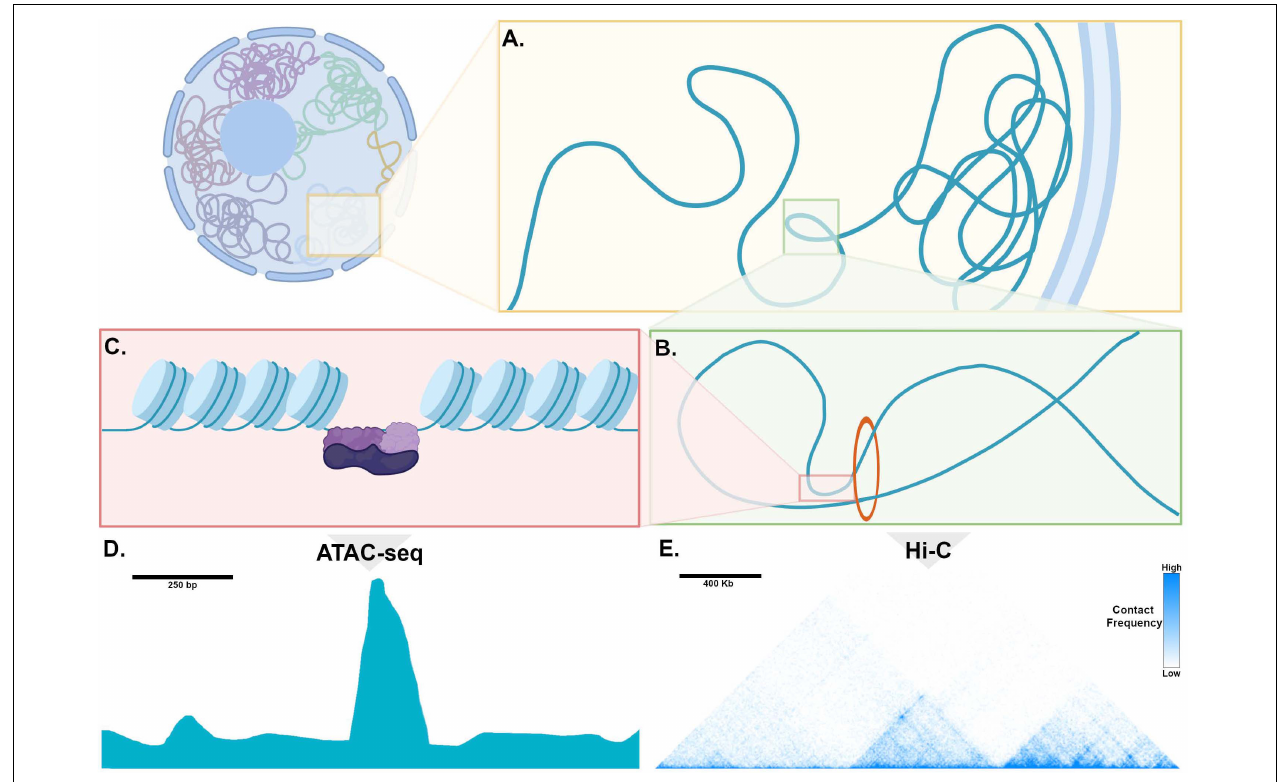
FIGURE 2 | Genome organization, chromatin, and mechanisms of transcription. (A) Within the nucleus, chromosomes occupy distinct territories and within a given territory, compacted, non-transcribed DNA is clustered into lamina-associated domains (LADs) adjacent to the nuclear periphery. DNA that is actively transcribed is located in the interior of the nucleus, where is it organized into topologically associated domains (TADs). (B) Enhancers and promoters are brought into proximity through loop extrusion by the ring-like Cohesion complex bound to Ctcf (red circle). (C) Chromatin is tightly wound around histone complexes. At sites of active enhancers, histone proteins are modified, allowing access of transcription factors (purple) to bind to DNA. (D) An example of processed ATAC-seq data aligned with the cartoon in (C) , expressed as a graph of read count versus genomic location, showing a “peak” or region of open chromatin, where histones are modified to make DNA accessible to a transposase. (E) An example of processed Hi-C data expressed as a heatmap, where the horizontal axis reflects genomic location. Pixel color represents the number of read counts, corresponding to the extent of contact frequency in cis between two regions of genomic DNA positioned along a chromosome. Topologically associated domains, visualized as discrete triangular shaped structures on the heatmap, are defined by regions that are permissive for long-range